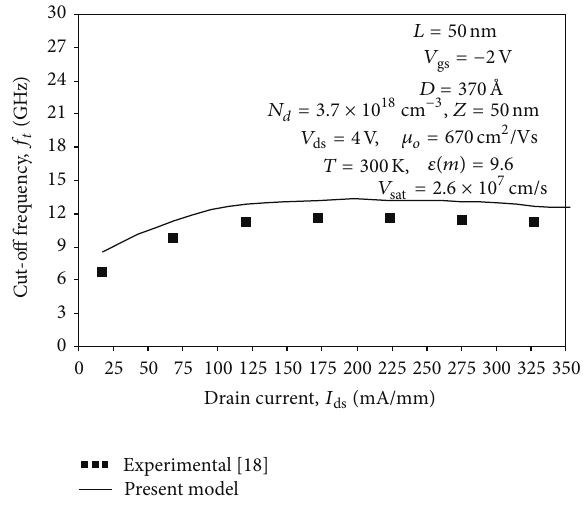
Figure 6: Variation of cut-off frequency with drain current.